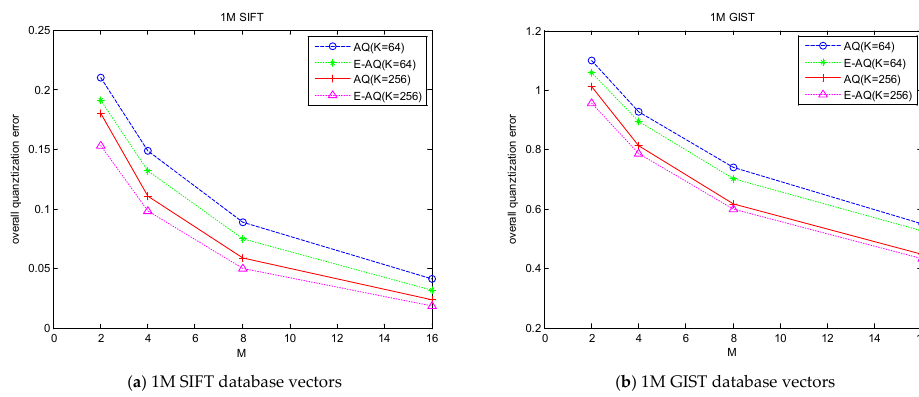
Figure 6. The quantization errors on 1M database vectors under different K and M.